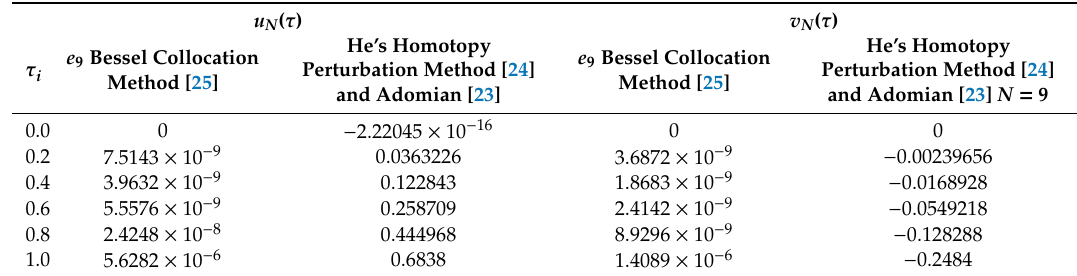
Table 11. Comparison of the residual errors of other methods.